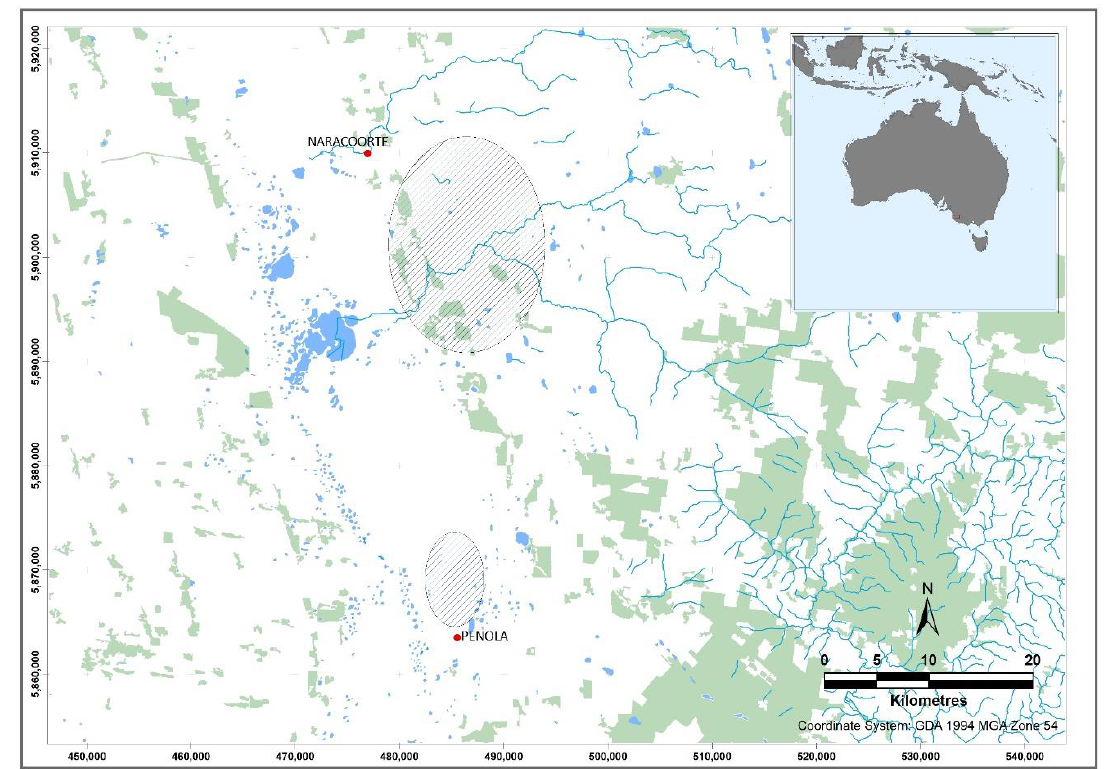
Figure 1. Location of area of investigation. Shaded oval circles indicate bore locations, however, accurate locations had to remain anonymous based on the request of landowners.